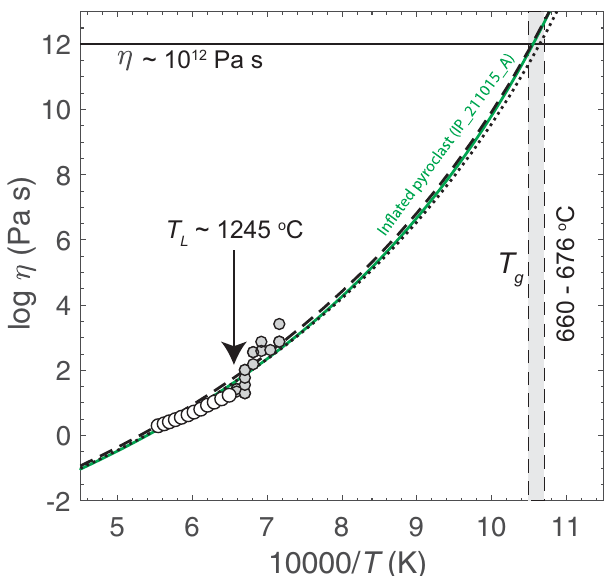
Fig. 7 Arrhenius plot describing the viscosity, η (Pa s) – temperature, T (K) relationship for natural and remelted samples of Tseax lava. Experimentally measured values of melt viscosity (white symbols) above liquidus temperatures ( T L ~1245 °C) and the viscosity of melt-crystal mixtures (grey symbols). The GRD model 54 values of melt viscosity for the composition of the natural in fl ated pyroclast are shown by the green labelled solid line (Table S1). Also shown are model viscosity curves for the remelted glass sample (TS-S71) predicted by the GRD model (thick dashed line) and the Raman-based model 55,56 ( fi ne dashed line). Model values of T 12 Pa s vary between 660 g taken as the temperature corresponding to ~ 10 and 676 °C (grey shaded fi eld). The corresponding rheometry data can be found in Table 1. Fig. 8 Heat conduction model for pyroclasts. The coloured lines track the surface temperature of the pyroclast. The black dashed lines represent the corresponding ambient air temperature, and the grey shaded region denotes the temperatures below the glass transition temperature, T g . Both T g values of 660 °C and 676 °C are marked to represent the range determined by high-temperature rheometry. a Cooling of a 2 mm diameter pyroclast within a lava fountain, the ambient temperatures ranging from 30°C (light yellow) to 900 °C (dark red) represent the thermal zonation in the fountain, from the cold edge to the hotter, insulated interior. b Cooling of 2 mm (dark green), 10 mm (light green) and 40 mm (blue) diameter pyroclasts generated from a low-velocity bubble burst. Note, the change of the x-axis to a log